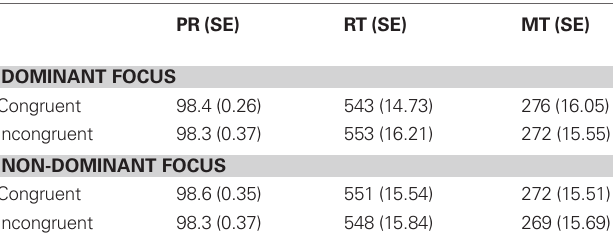
Table 3 | Average performance rates (Pr), reaction times (rTs), and movement times (MTs) with standard errors for congruent and incongruent trials in both the dominant focus and non-dominant focus condition.